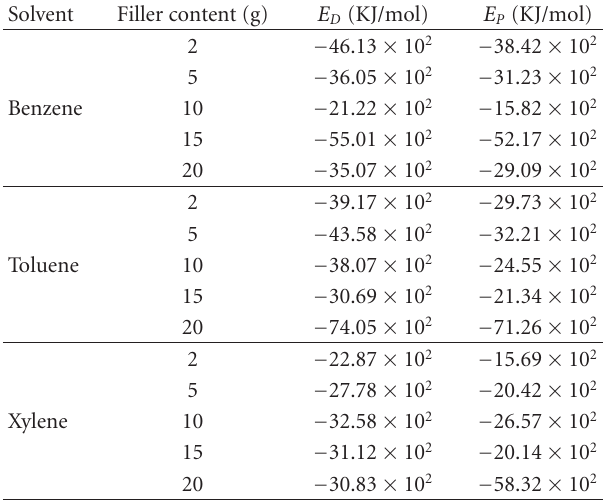
Table 6: Values of activation energy ( E D and E P ) of snail shell powder filled natural rubber (filler particle size, 0.300 μ